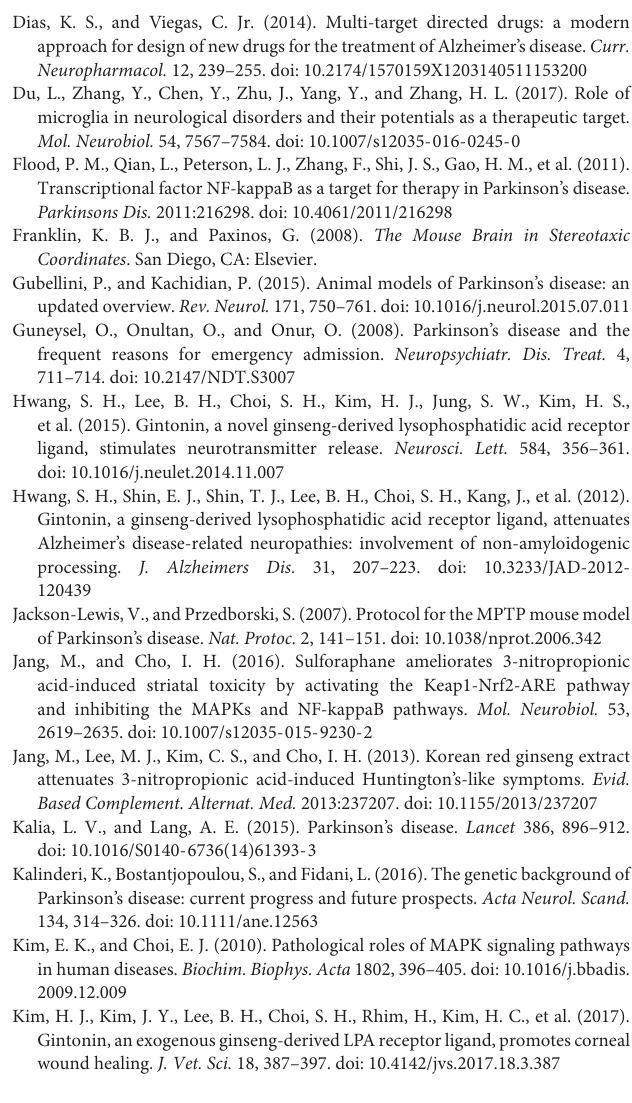
FIGURE S1 | Gintonin do not significantly affect LPAR2 and 4–6 signaling pathways in the SNpc and striatum after MPTP injection. (A–H) SNpc and striatum sample ( n = 3 per group) from 7 days after MPTP-injection were quantified by real-time PCR to measure the alteration in expression of LPARs. mRNA expression of LPAR2 (A,E) , 4 (B,F) , 5 (C,G) , and 6 (D,H) . SNpc (A–D) and striatum (E–H) . FIGURE S2 | Original images of Western blots: Western blot analysis was performed using membrane strips containing specific